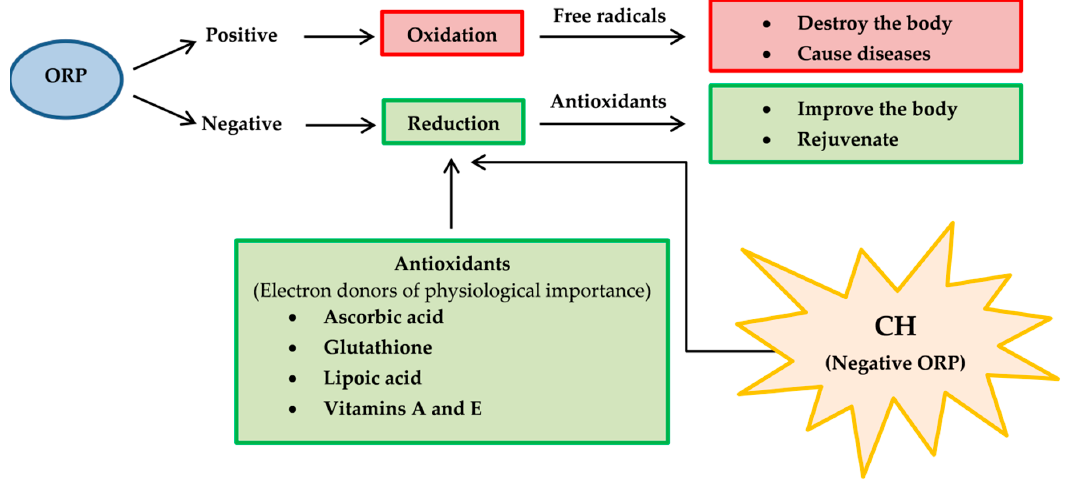
Figure 11. The potential applications of oxidation-reduction potential (ORP) or redox reaction for CH determination in pharmaceuticals.